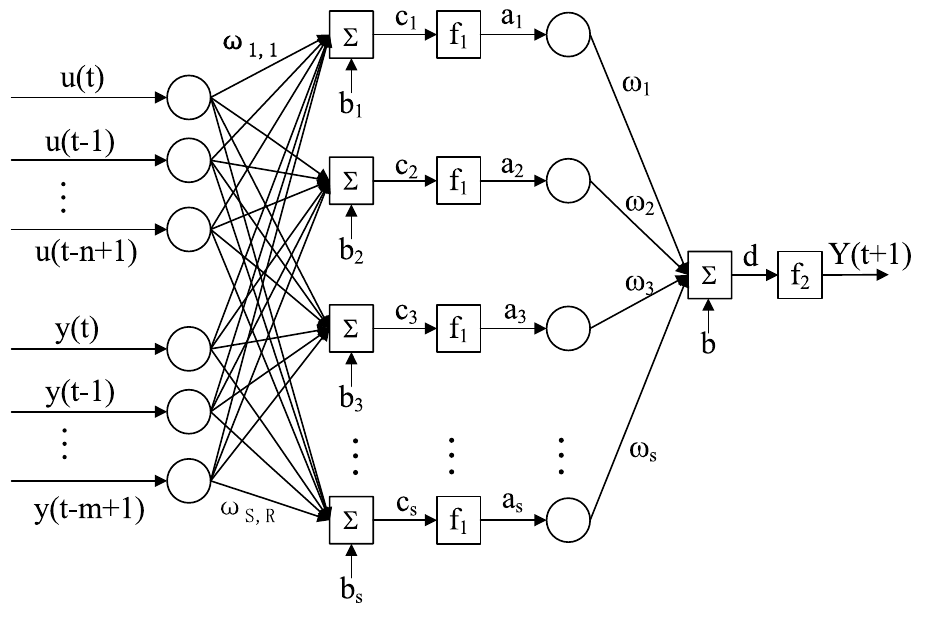
Figure 4. Series parallel neural network